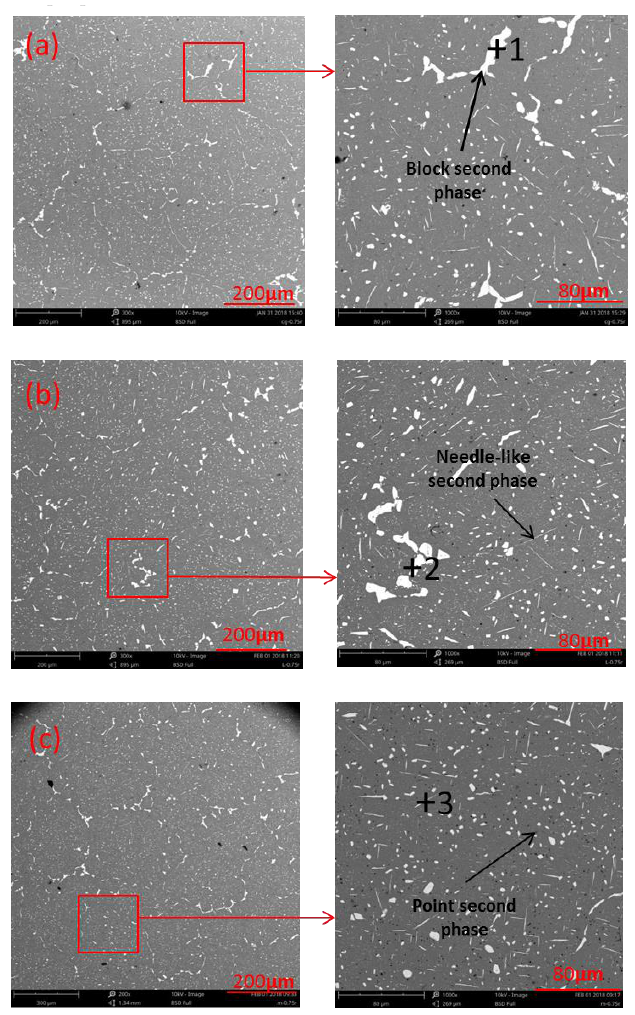
Figure 10. Secondary phases of ingots at the position of 0.75 R under different processing parameters: ( a ) NO-UTS; ( b ) I-UTS; ( c ) L-UTS. Table 4. The mole fraction of the second phase in different ingot crystals (%).